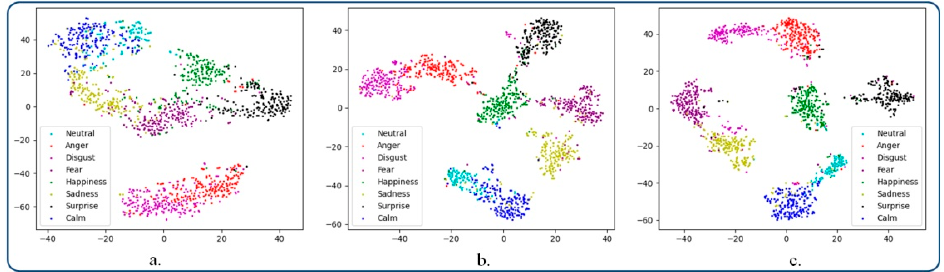
Figure 7. Visualization of the feature embedding using t ‐ SNE on the RAVDESS dataset: ( a ) softmax loss, ( b ) triplet loss, and ( c ) emotion metric learning. loss, ( b ) triplet loss, and ( c ) emotion metric